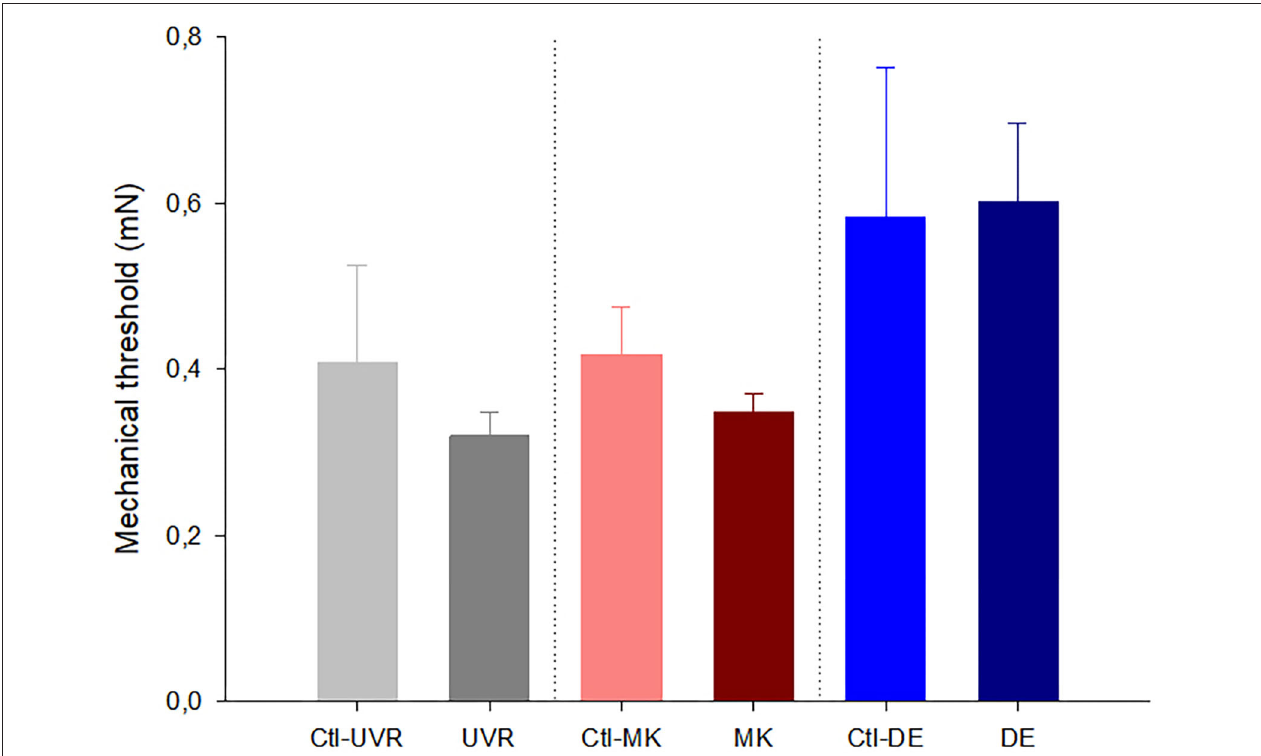
FIGURE 1 | Effects of unilateral UV irradiation, microkeratome lesion, and main lacrimal gland removal on the mechanical threshold of the mechanonociceptor units recorded in the ipsilateral and contralateral (denoted by “Ctl” label) eyes. The data are presented as mean ± SEM. No significant differences were found between the data from the ipsilateral and contralateral eyes inside each group, Mann-Whitney